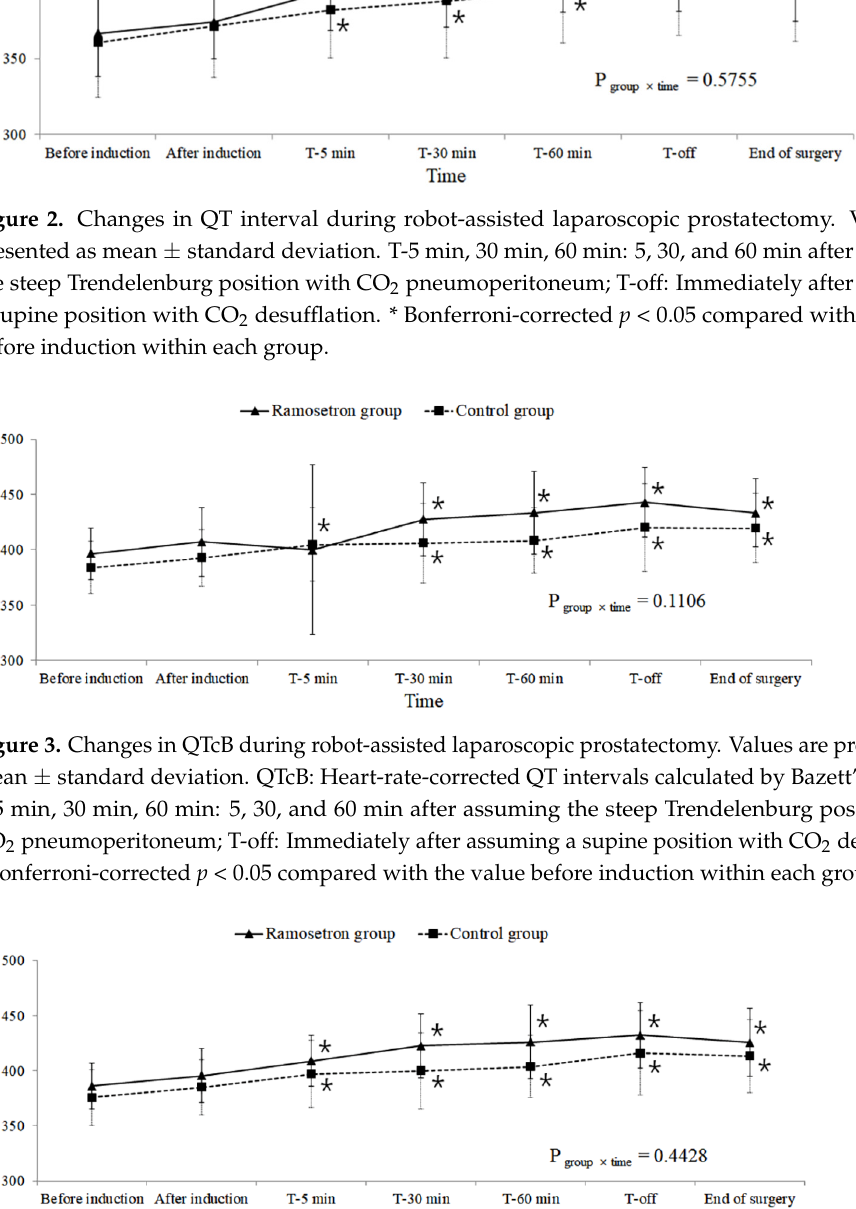
Figure 4. Changes in QTcF during robot-assisted laparoscopic prostatectomy. Values are presented as mean ± standard deviation. QTcF: Heart-rate-corrected QT intervals calculated by Fridericia’s formula; T-5 min, 30 min, 60 min: 5, 30, and 60 min after assuming the steep Trendelenburg position with CO 2 pneumoperitoneum; T-off: Immediately after assuming a supine position with CO 2 desufflation. * Bonferroni-corrected p < 0.05 compared with the value before induction within each group. These increases in the QTc interval, compared with before induction, were sustained until the end of surgery. No significant differences were observed in the number of subjects whose QTc intervals increased to greater than 450 or 500 ms between the groups (Table